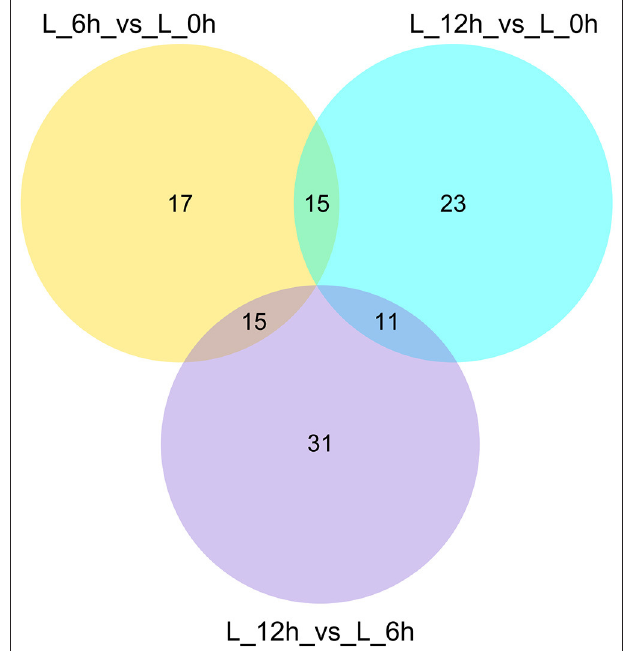
FIGURE 4 | Venn diagrams of DElncRNAs in response to different